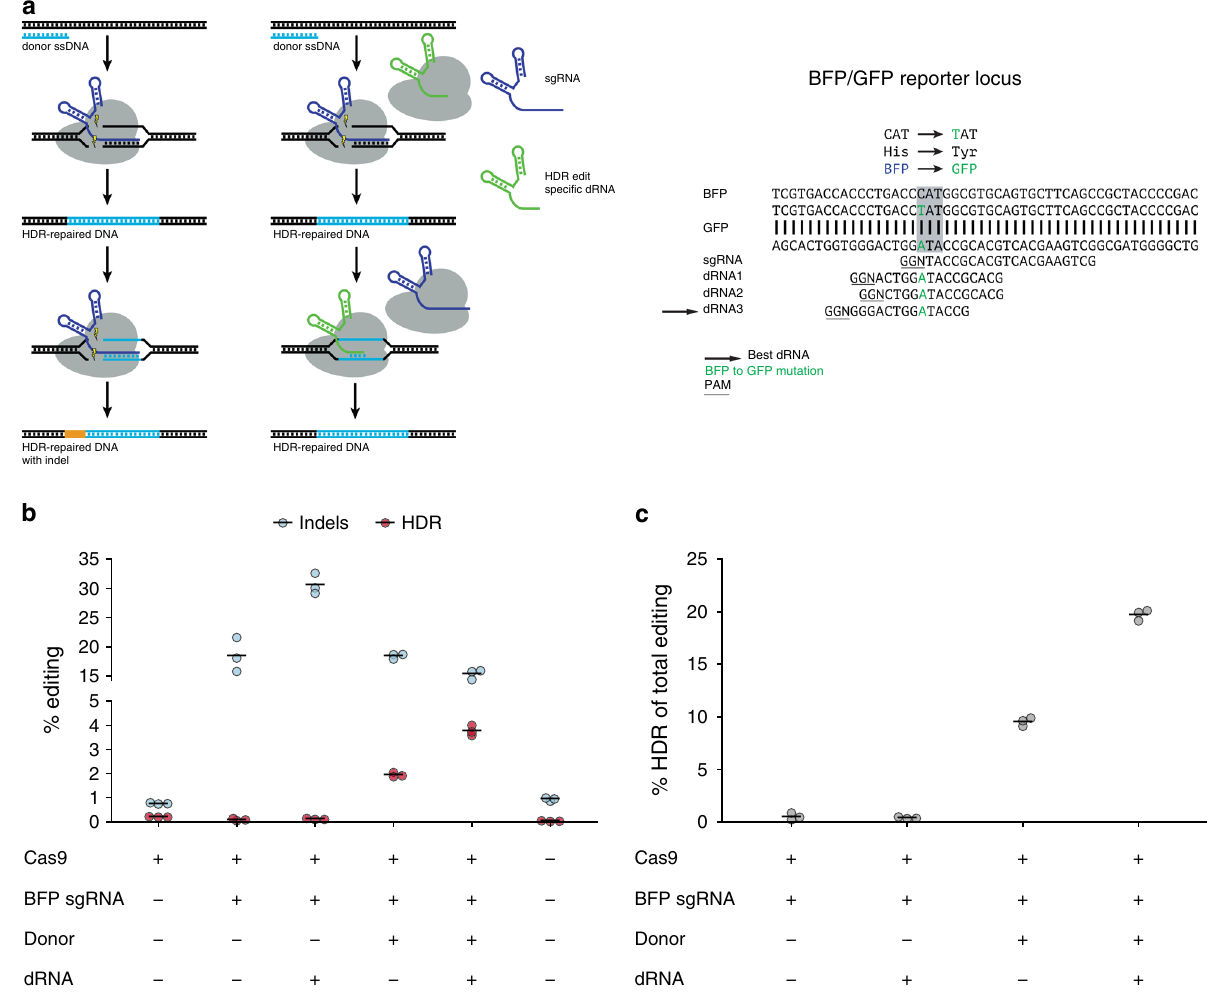
Fig. 6 dRNA on-target recutting suppression (dReCS) facilitates scarless HDR. a Schematic depicting dReCS and alignment of BFP, GFP, sgRNA, and dRNA sequences. dRNA (green) exhibiting perfect complementarity for the repaired site directs Cas9 binding but not cleavage, protecting the repaired site. Single base change to generate GFP from BFP is displayed in green with affected codon indicated by gray box. PAM sequences are underlined. Black arrow indicates best dRNA, as determined by maximal improvement in HDR yield. b Indels and homology-directed repair (HDR) as assessed by fl ow cytometry, where indels lead to a loss of BFP signal, and HDR leads to a loss of BFP and gain of GFP signal. c HDR as a percentage of total Cas9 edits observed. Means of n = 3 cell culture replicates depicted by solid lines. dRNA BFP sgRNA1 dRNA3 (see Supplementary Fig. 13, Supplementary Data Set 1). Source data are available in the Source Data fi